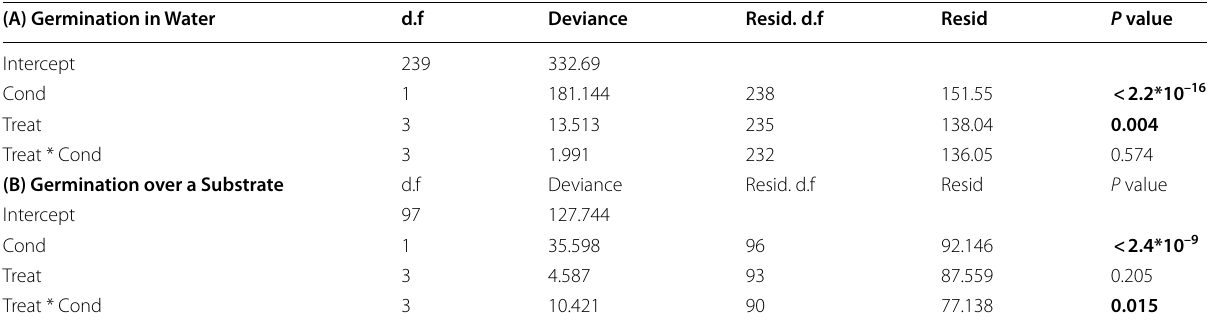
Table 4 GLM analysis comparing germination rates between experiments (A) ‘Germination in Water’ and (B) ‘Germination Over a Substrate’. In both cases, GLM design is factorial: treatment (Treat, days of immersion in water) and condition (Cond, seed scarified or unscarified). Significant results are highlighted in